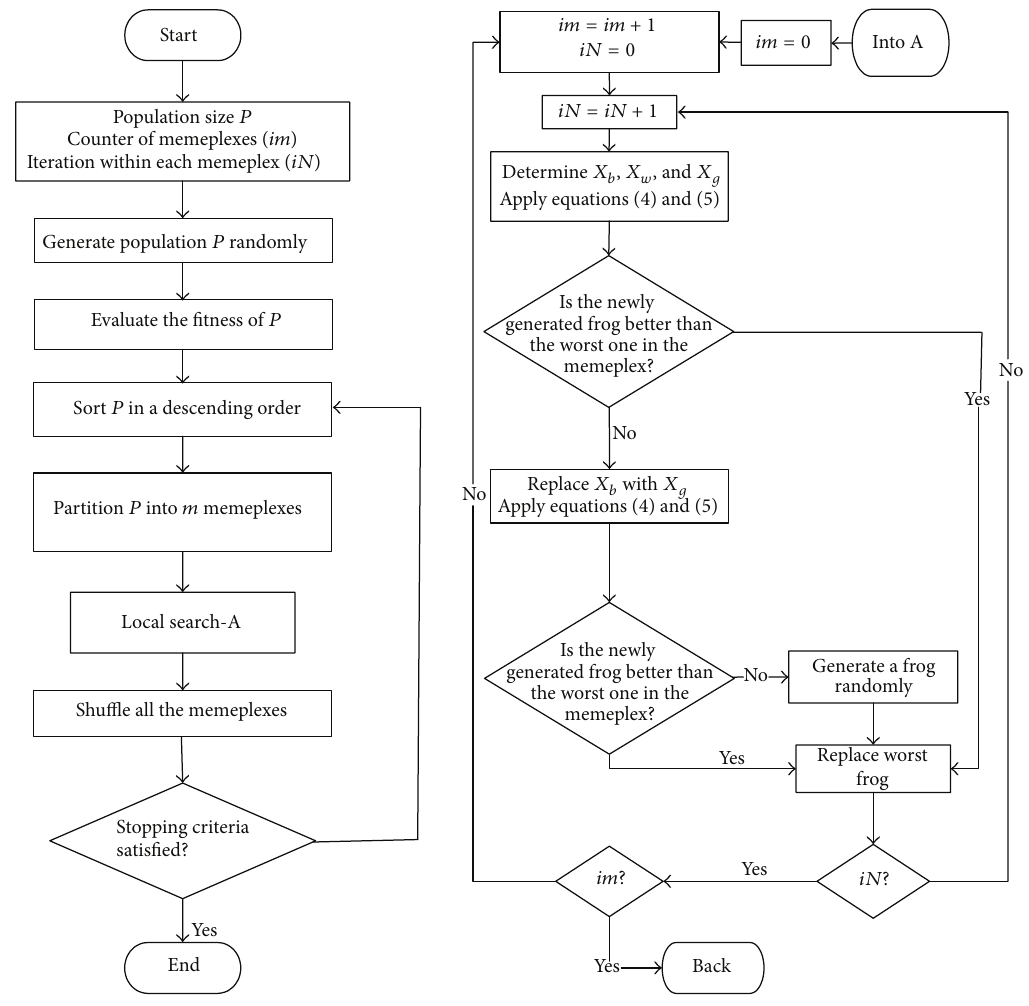
Figure 1: Flowchart of